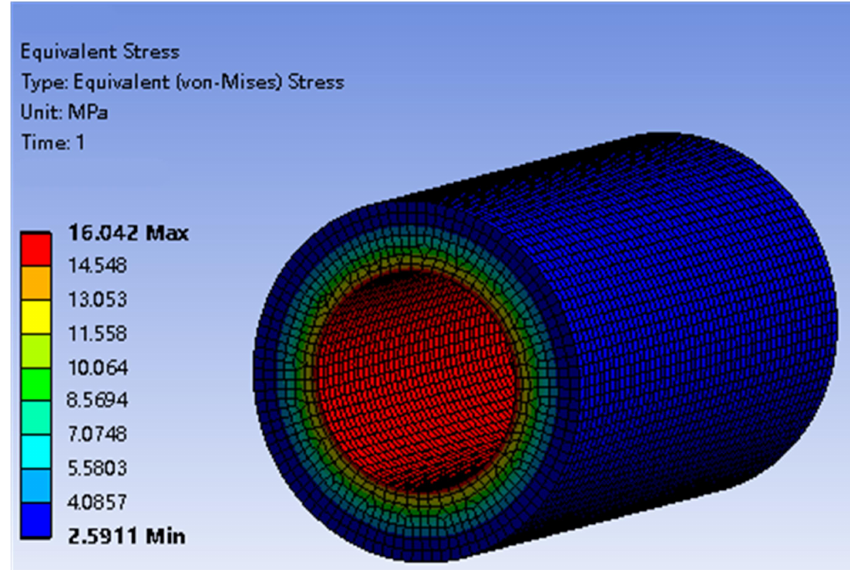
Figure 12. Mechanical Stress of the Smooth Solid Rotor.